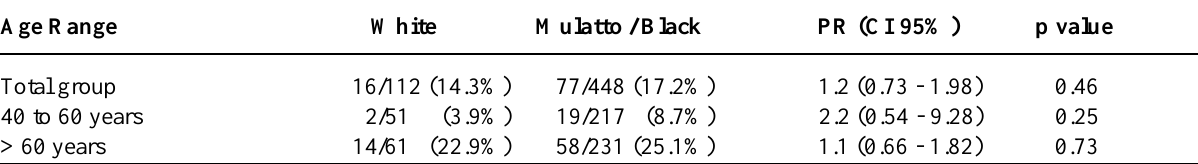
Table 5 – Association between race and diagnosis of prostate adenocarcinoma according to age.